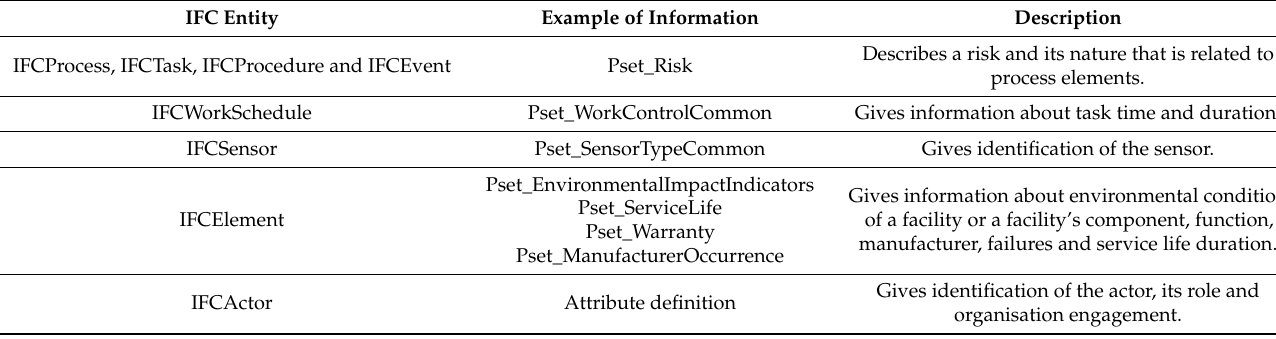
Table 3. Extract of O&M information modelling capabilities of IFC standard.